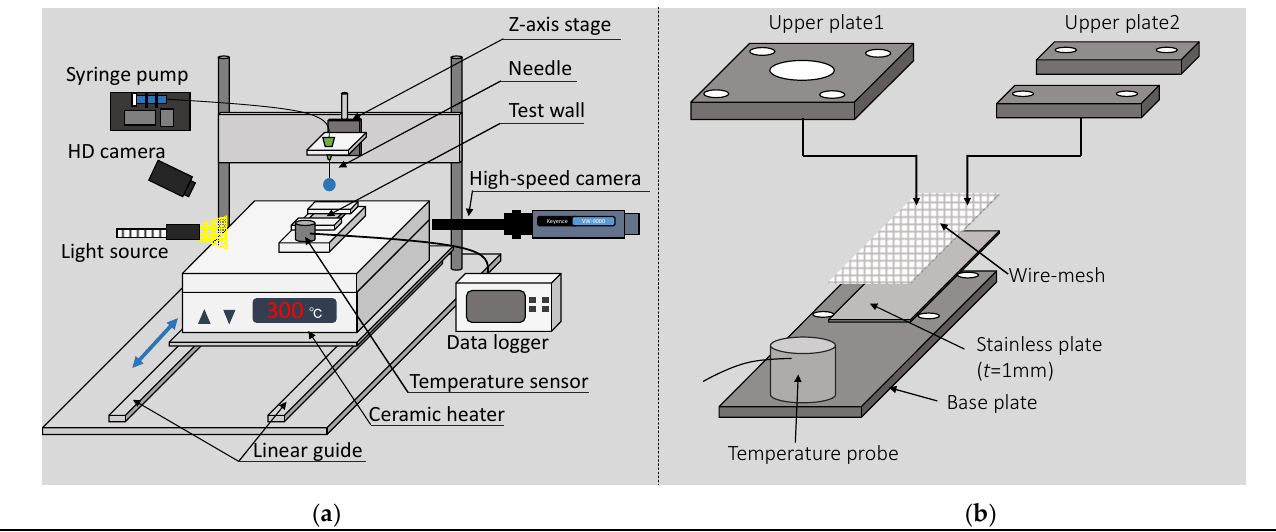
Figure 1. Schematic illustration of the ( a ) experimental setup and ( b ) details of the test section. Upper plate 1 is used for measuring evaporation time. Upper plate 2 is used for high-speed imaging of drop impact.